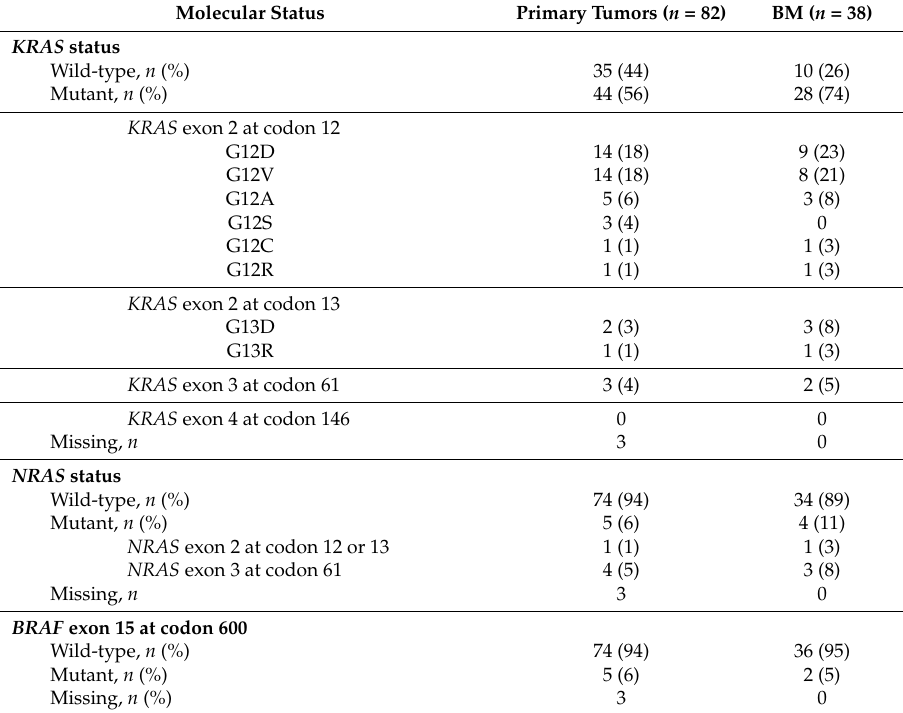
Table 2. Molecular profile of primary tumors and brain